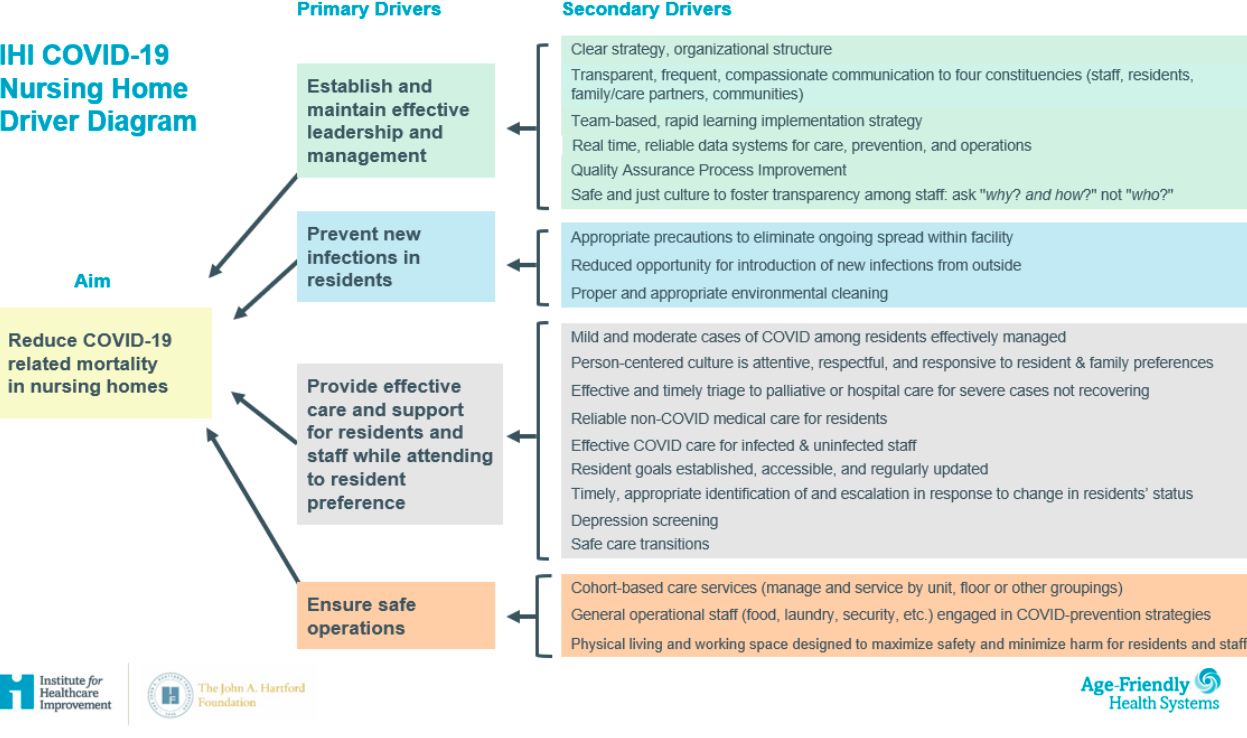
Figure 1. Driver diagram on reducing COVID-19 mortality in nursing homes.